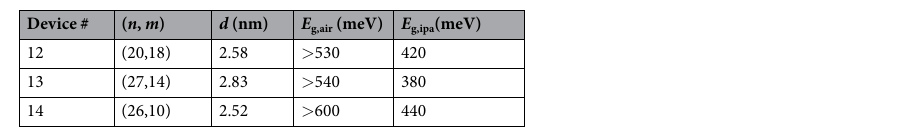
Table 1. Modifying the transport gap of wide-gap CNTs. The transport gap was first characterized in air, E g,air , and then in isopropanol, E g,ipa . All devices have L = 2 μ